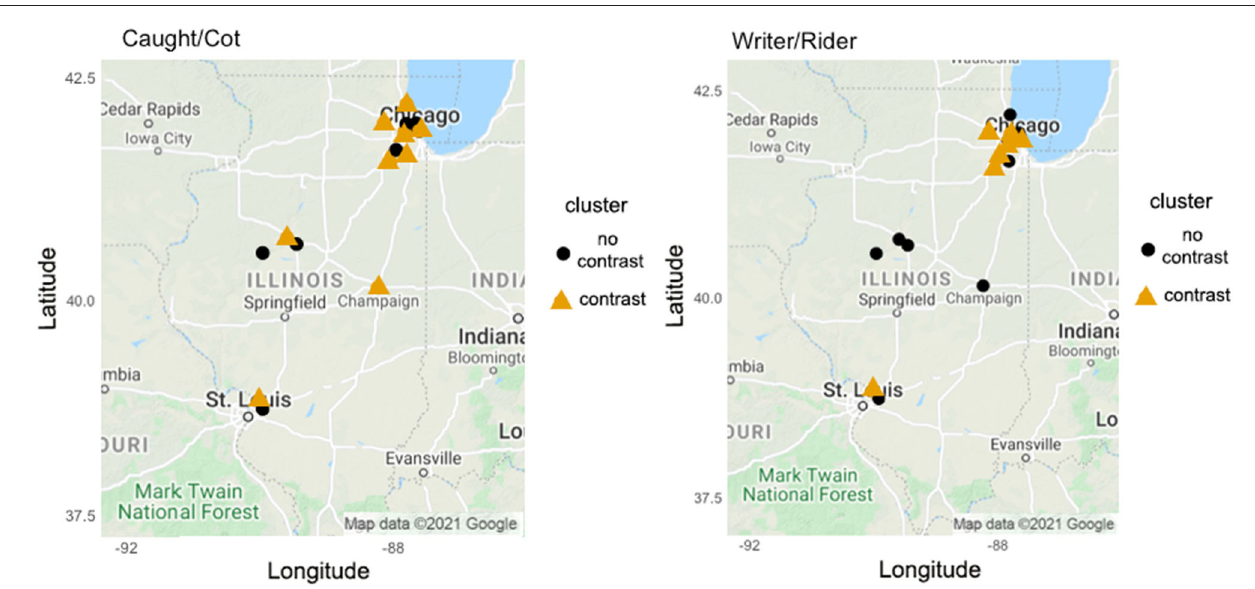
FIGURE 1 | Participant locations by production cluster for cot-caught (left) and writer-rider (right). Participant locations by production cluster (black circle: no contrast [low Pillai score]; orange triangle: contrast [high Pillai score]; Google,